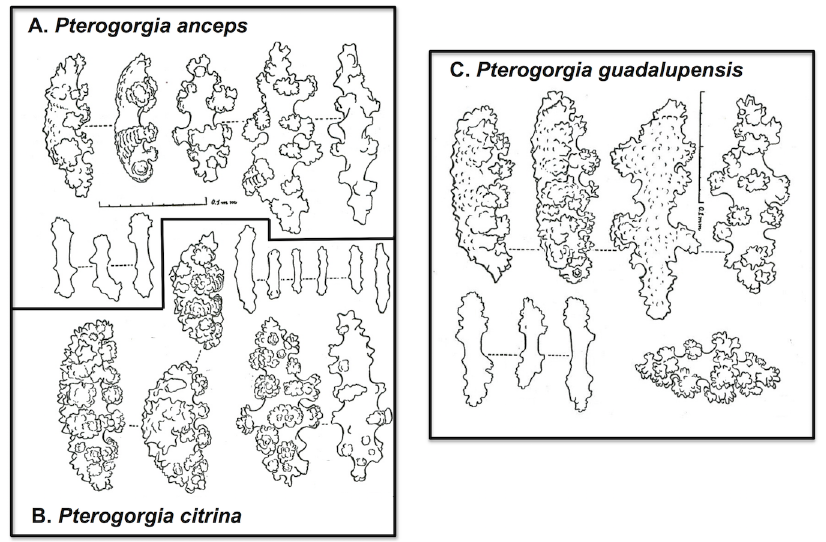
Fig 1. Pterogorgia sclerites. Drawings depicting the similarity in sclerite form among the three species of Pterogorgia , (A) P . anceps , (B) P . citrina , and (C) P . guadalupensis . As a result, and unlike many gorgoniid octocorals, sclerite morphology is not used as a character to separate and define species of Pterogorgia . Drawings adapted from [7].